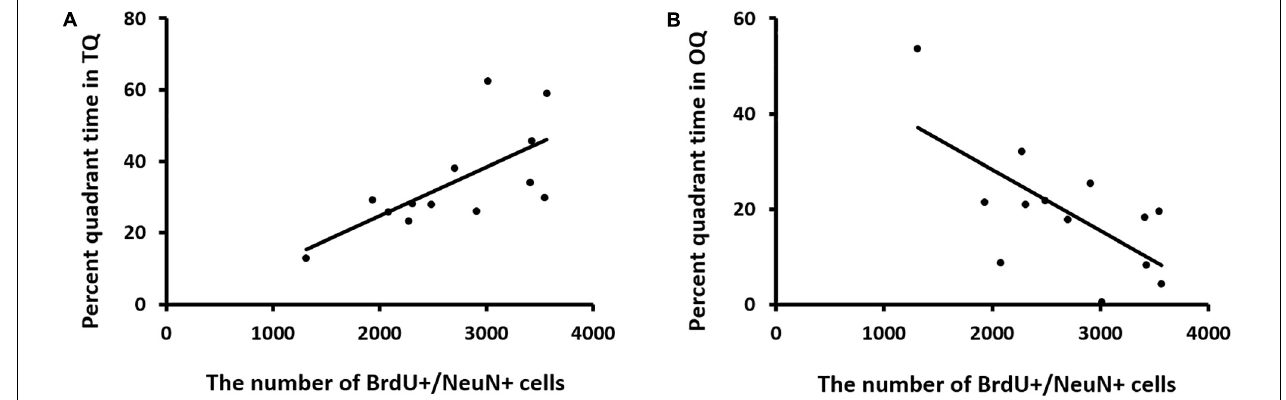
FIGURE 10 | Correlation between neurogenesis and memory retention in reversal learning. (A,B) Neurogenesis is positively related to the percentage of time spent in the target quadrant (TQ), while it is negatively related to the time spent in the opposite quadrant (OQ). Data were analyzed using Pearson correlation